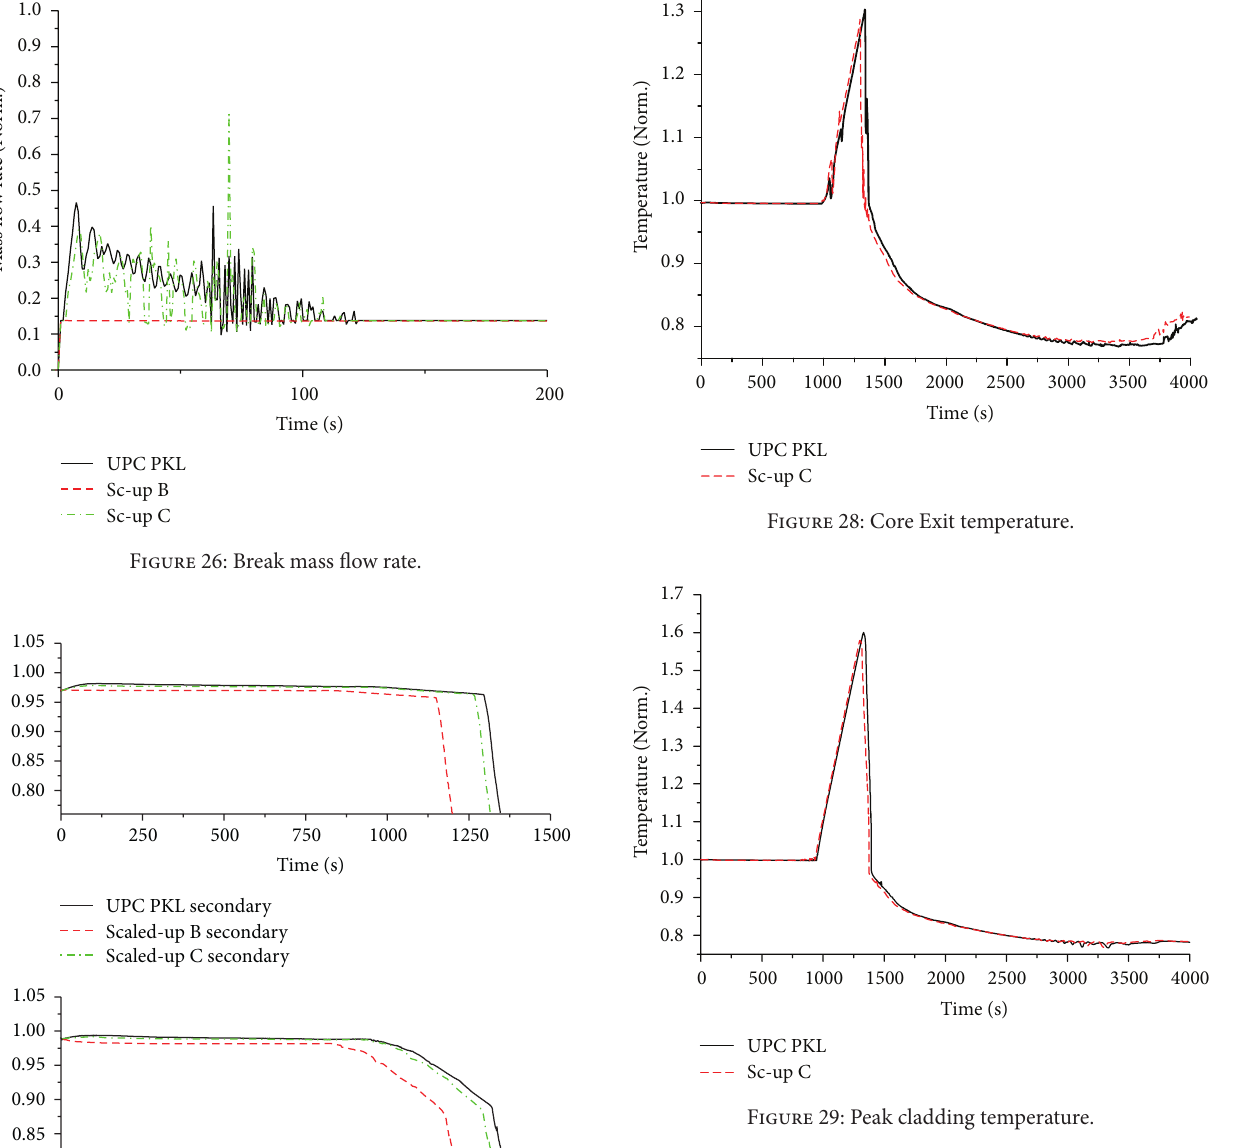
modified by adding the LSTF external heat losses, merging 4 loops into 2 loops, and adjusting the hot leg geometries in order to preserve the LSTF 𝐿/√𝐷 factor and finally by removing the compensating heaters during the transient as in the LSTF conditions. The comparison between the 3 nodalizations shows that the external heat losses and the Figure 27: System pressures. different hot leg geometries do not justify the delay